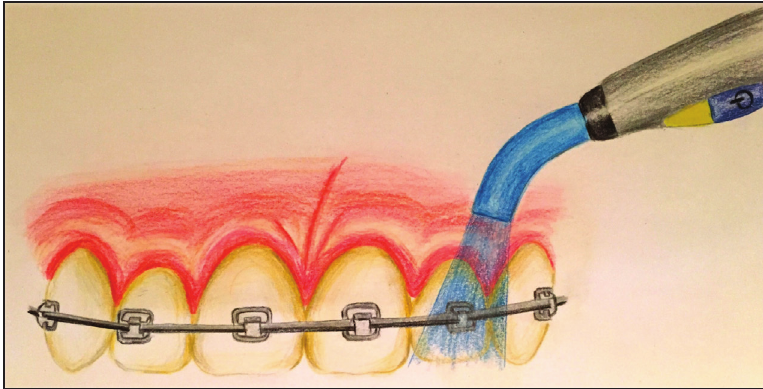
Figure 2. Using finger pressure to hold the denture tooth in position, the archwire is engaged into the bracket slot before curing. The bracket is then secured to the archwire using elastic or steel ligatures.